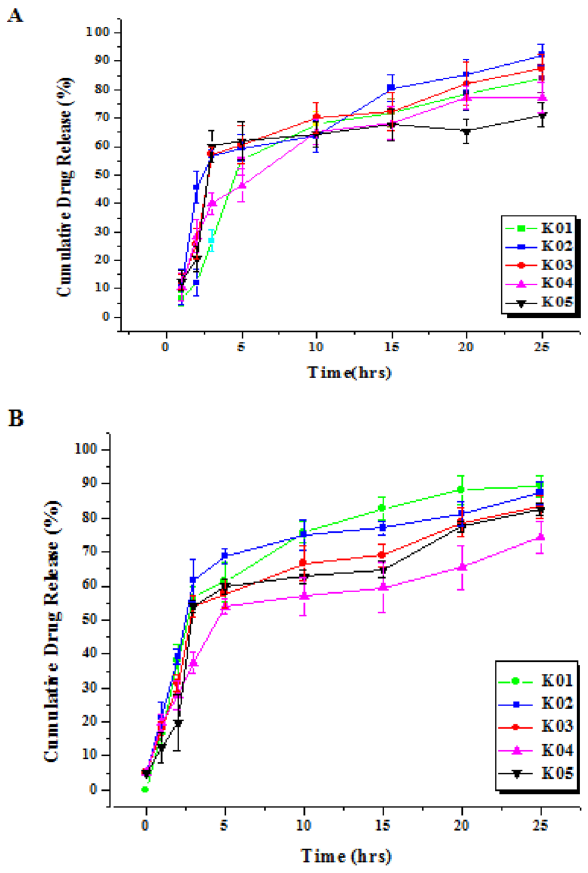
Figure 3. In-vitro release profiles of different nanoformulations estimated by ( A ) plasma simulation method, ( B ) Dialysis membrane method. Values are expressed as mean ± SE, n = 3.